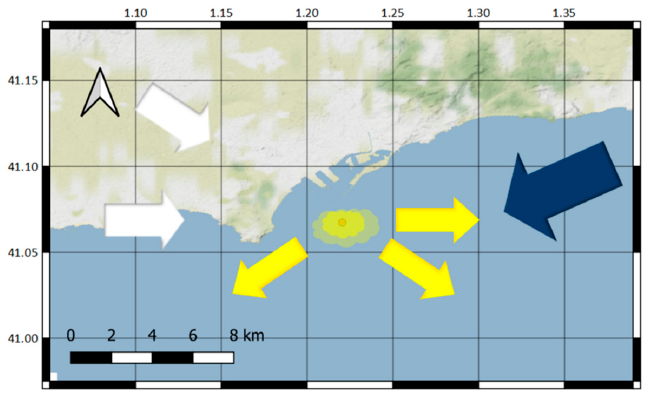
Figure 10. Oil transport pattern for spills at the monobuoy. Main directions are represented with yellow arrows. The blue arrow represents the main water current. White arrows represent the main wind directions.